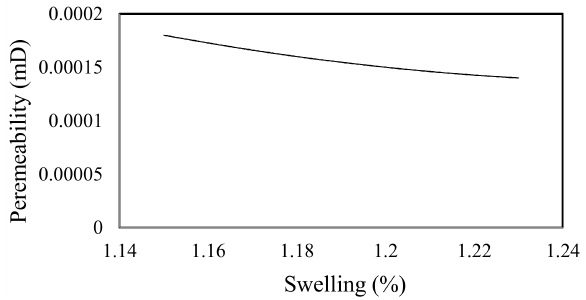
Figure 4. The direct relationship between coal swelling and permeability [36].